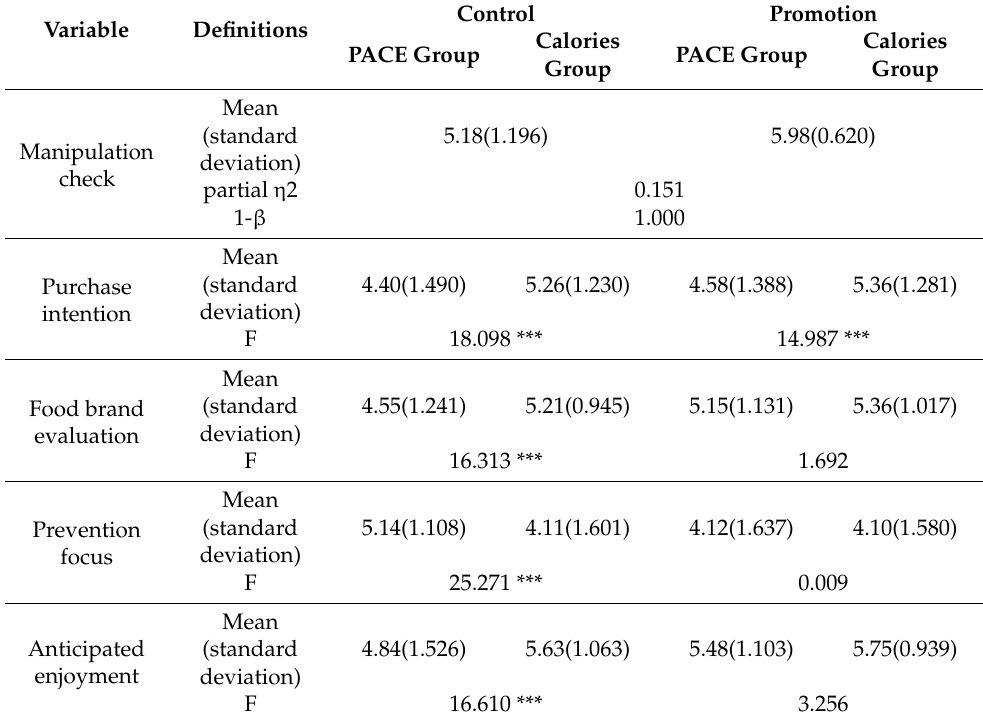
Table 4. Main results of Study